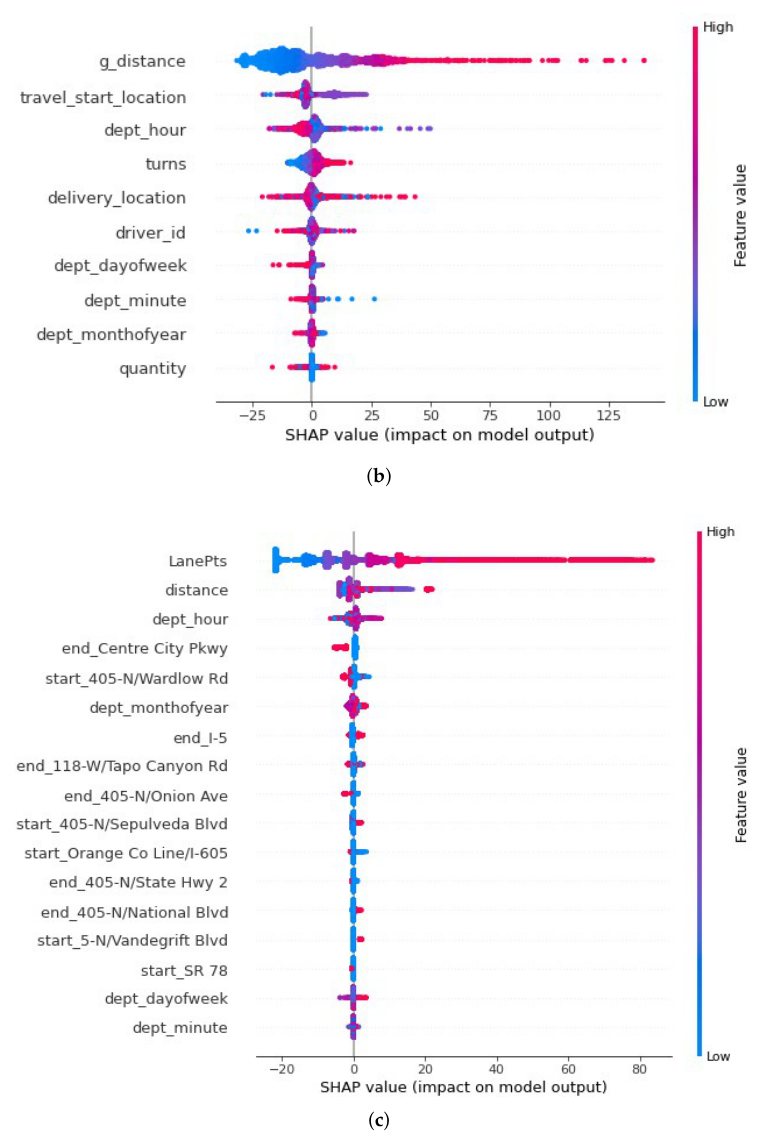
Figure 4. Global Explanations with SHAP for the XGBoost Model and Data Sets NextUp-1, NextUp2, and PeMS. ( a ) Summary plot Dataset-1. ( b ) Summary plot Dataset-2. ( c ) Summary plot PeMS Dataset.